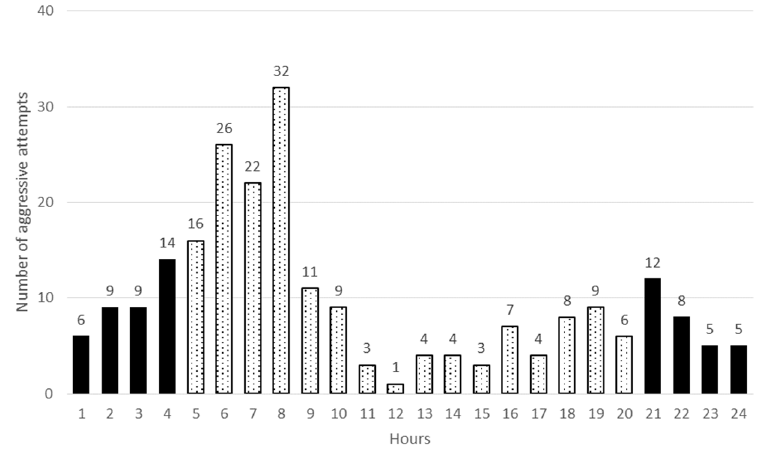
Figure 3. Number of aggressive interactions in relation to time of day in HOM groups (light and dark columns show the light and dark periods of day).